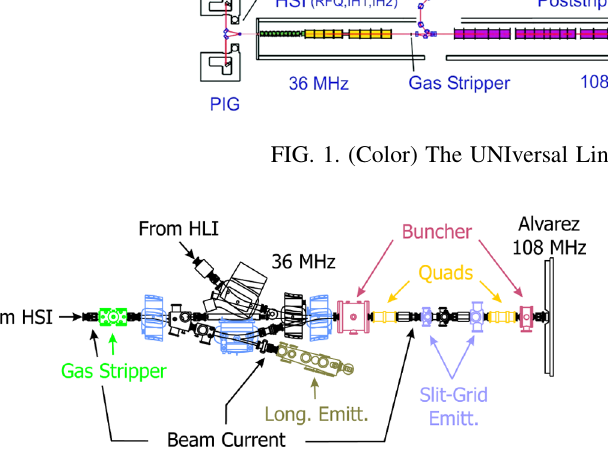
FIG. 2. (Color) The stripper section including the matching section to the Alvarez DTL.